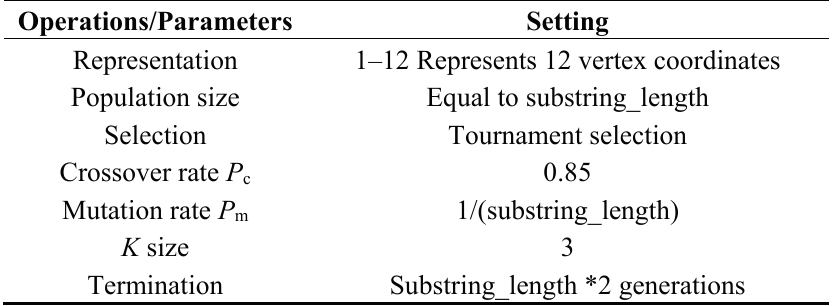
Table 3. Parameter setting for the four evolutionary algorithms used in